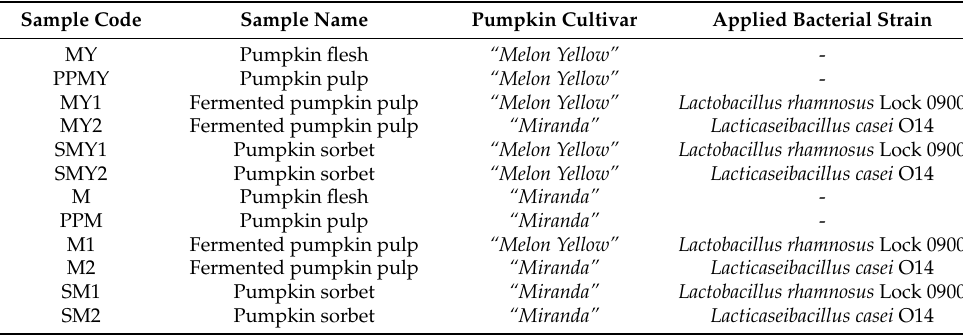
Table 1. Description of the investigated